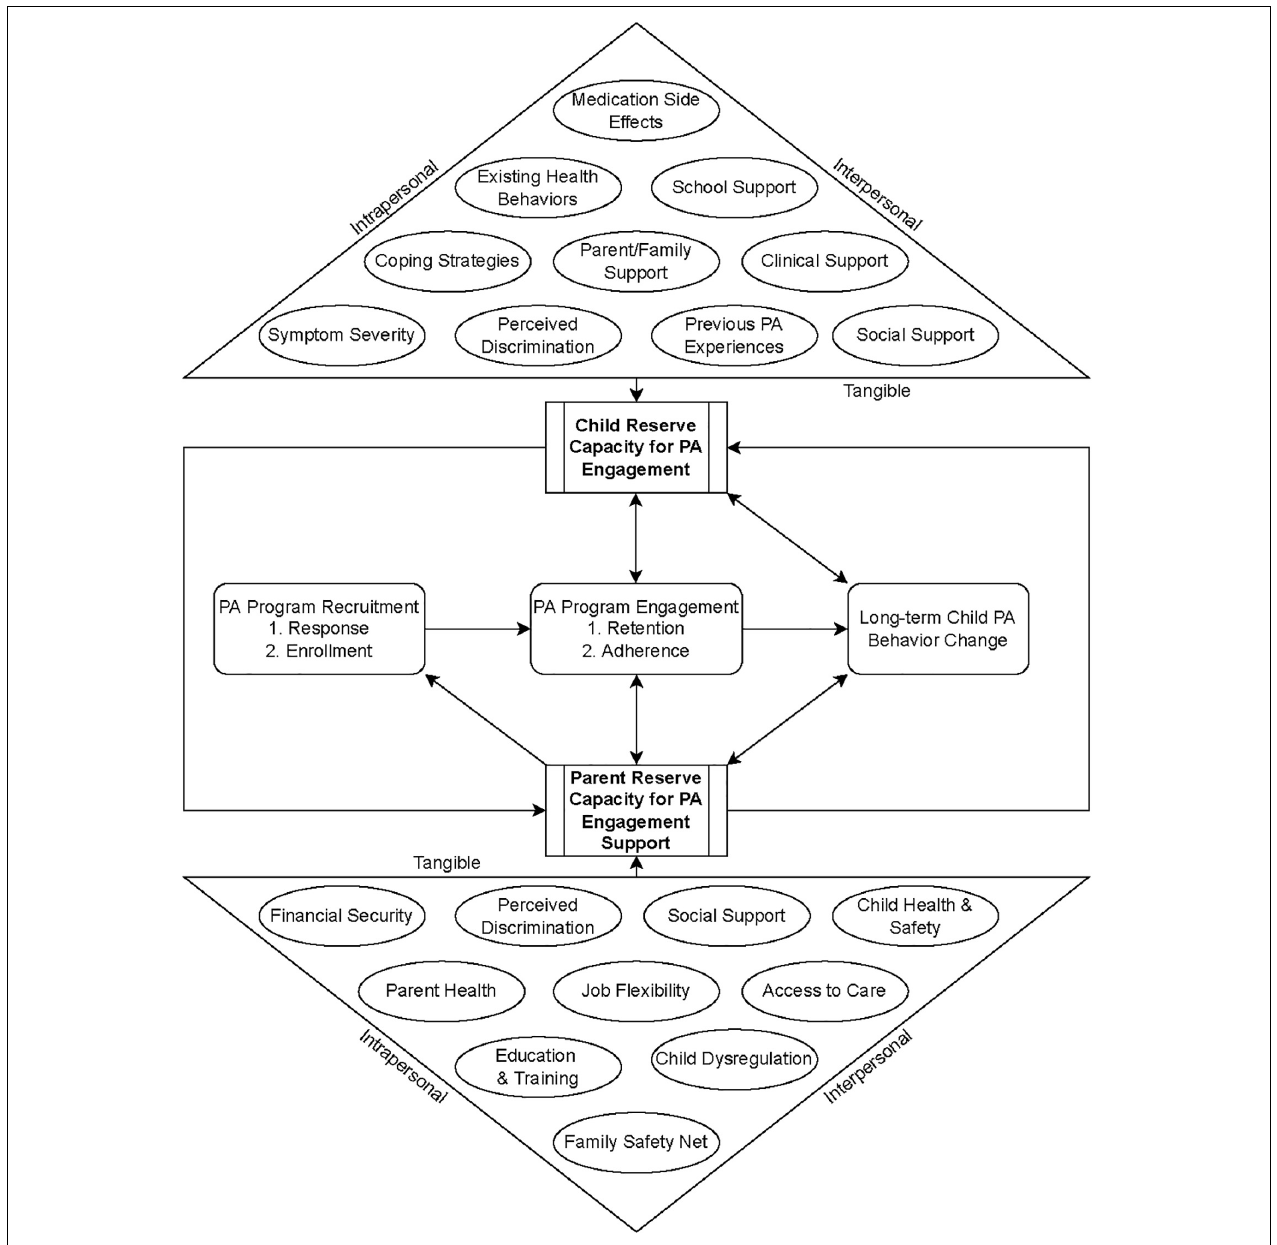
FIGURE 1 | Conceptual model of pediatric SEBD and PA programming